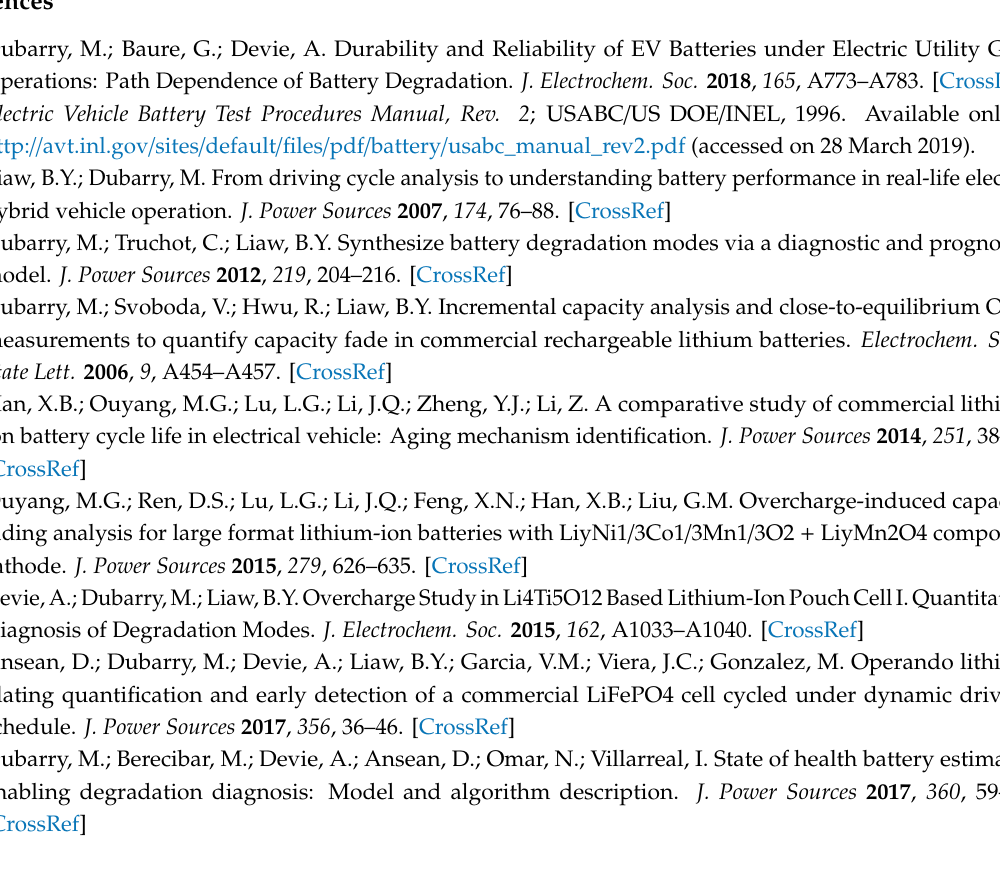
Supplementary Materials: The derivation of Equation (1) and Figure S1 are available online at www.mdpi.com / 2313-0105 / 5 / 2 /